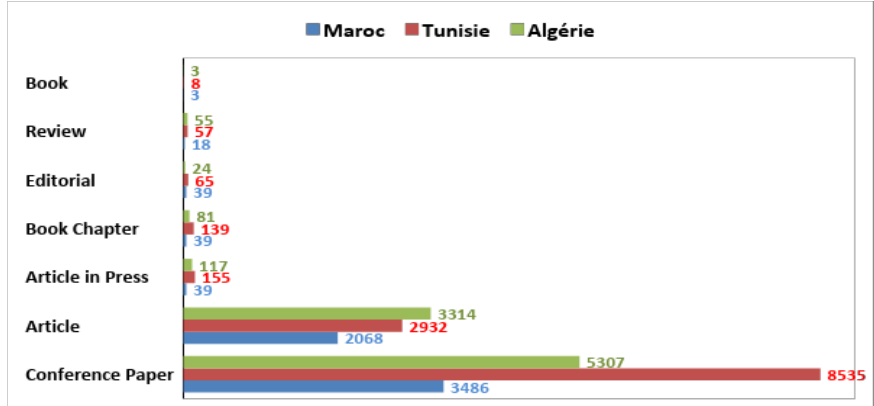
Fig. 6. Comparison between Morocco, Tunisia and Algeria by type of publication In addition, the data extracted from SCOPUS database showed that Conference Paper are the most popular types of publications in the three countries (55.2% Morocco, 71.77% Tunisia, 59.25% Algeria), followed by scientific articles, article in press and book